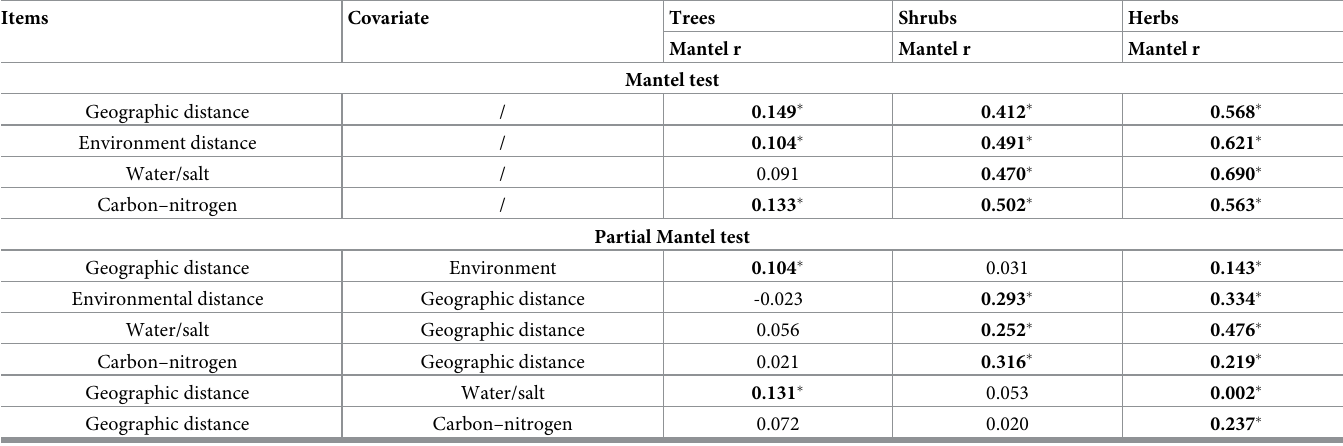
Table 1. Mantel test and partial mantel test correlations for the community dissimilarity, geographical distance, and environmental dissimilarity of different plant types. Items Covariate Trees Shrubs Herbs Mantel r Mantel r Mantel r Mantel test Geographic distance 0.149 � 0.568